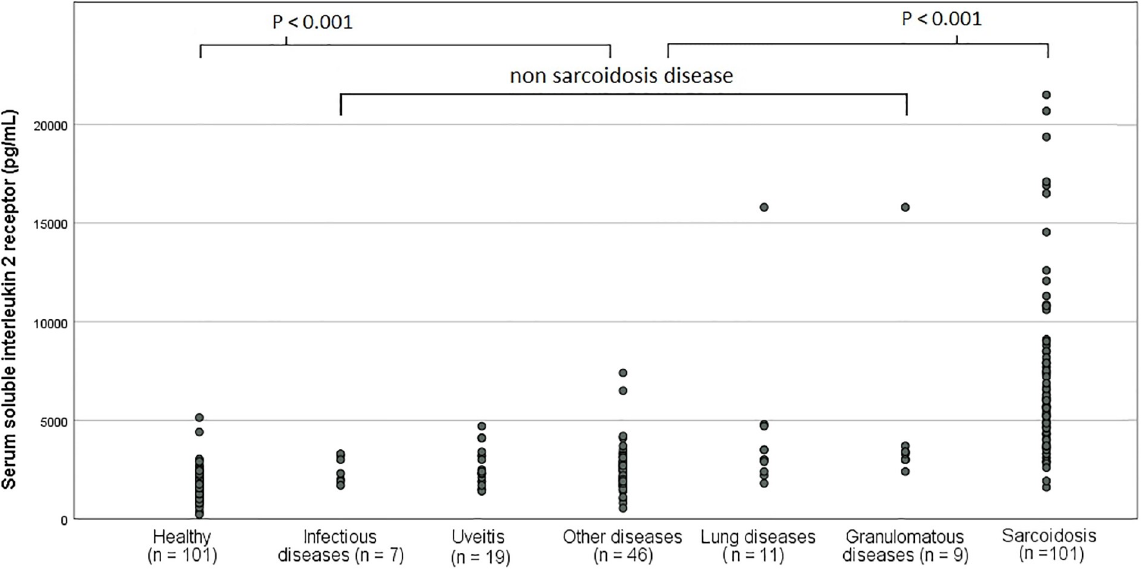
Fig 2. Dot plot of serum soluble interleukin 2 receptor levels in various diseases and healthy controls. � . Four patients have been assigned towards multiple groups: Two tuberculosis and one extrinsic allergic alveolitis patients were assigned towards lung diseases and granulomatous diseases. One Patient with toxoplasmosis was assigned towards granulomatous diseases as well as towards infectious diseases.